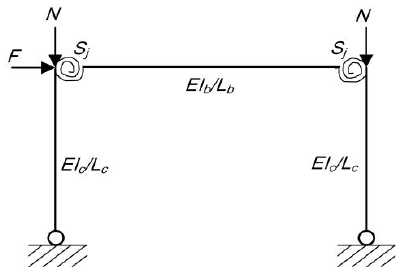
Figure 3. Check of a ‘actual’ semi -rigid joint in Steenhuis et al. [32]. All columns are assumed to share the same profile with a gravity-concentrated load applied on their tops. The rotational stiffness of the beam – column joints is 𝑆 𝑗 and the line stiffness of beam and column are 𝑘 𝑏 = 𝐸𝐼 𝑏 𝐿 𝑏 ⁄ and 𝑘 𝑐 = 𝐸𝐼 𝑐 𝐿 𝑐 ⁄ , respectively. The linear stiffness ratio 𝜌 of beam to column is defined as Equation (3):